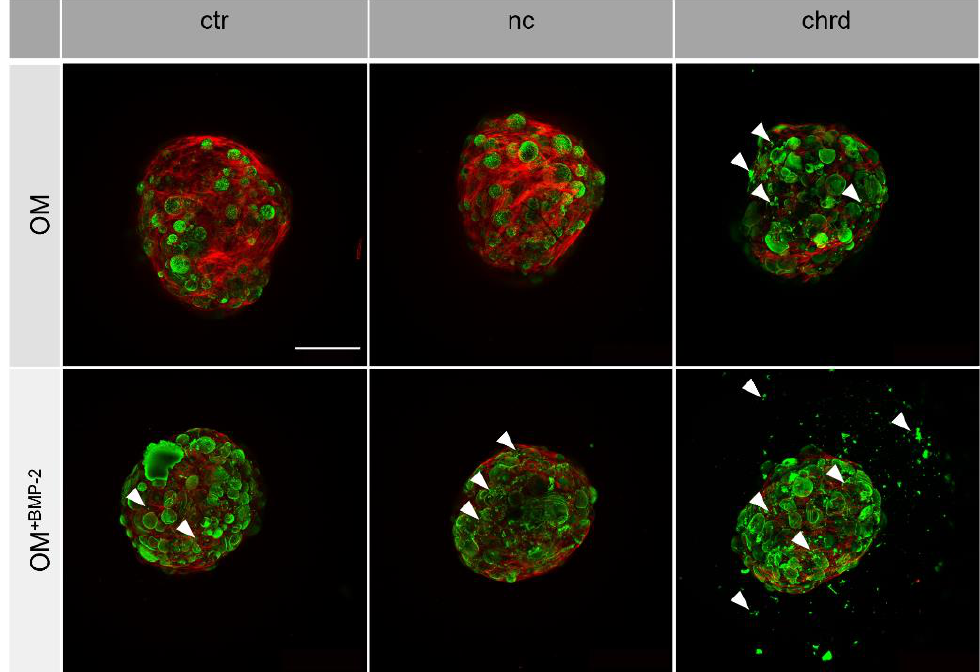
Figure 4. Representative images of hydroxyapatite (HA) formation (OsteoImage staining) in microtissues from hMSC (green: HA, red: actin cytoskeleton) with or without chordin siRNA by confocal laser scanning microscopy (HA formations in the interspace of agglomerated cGMs are highlighted by white arrows). Stem cells were cultivated in an osteogenic medium (OM) with or without BMP-2 for 21 days. Scale bar represents 500 µm.